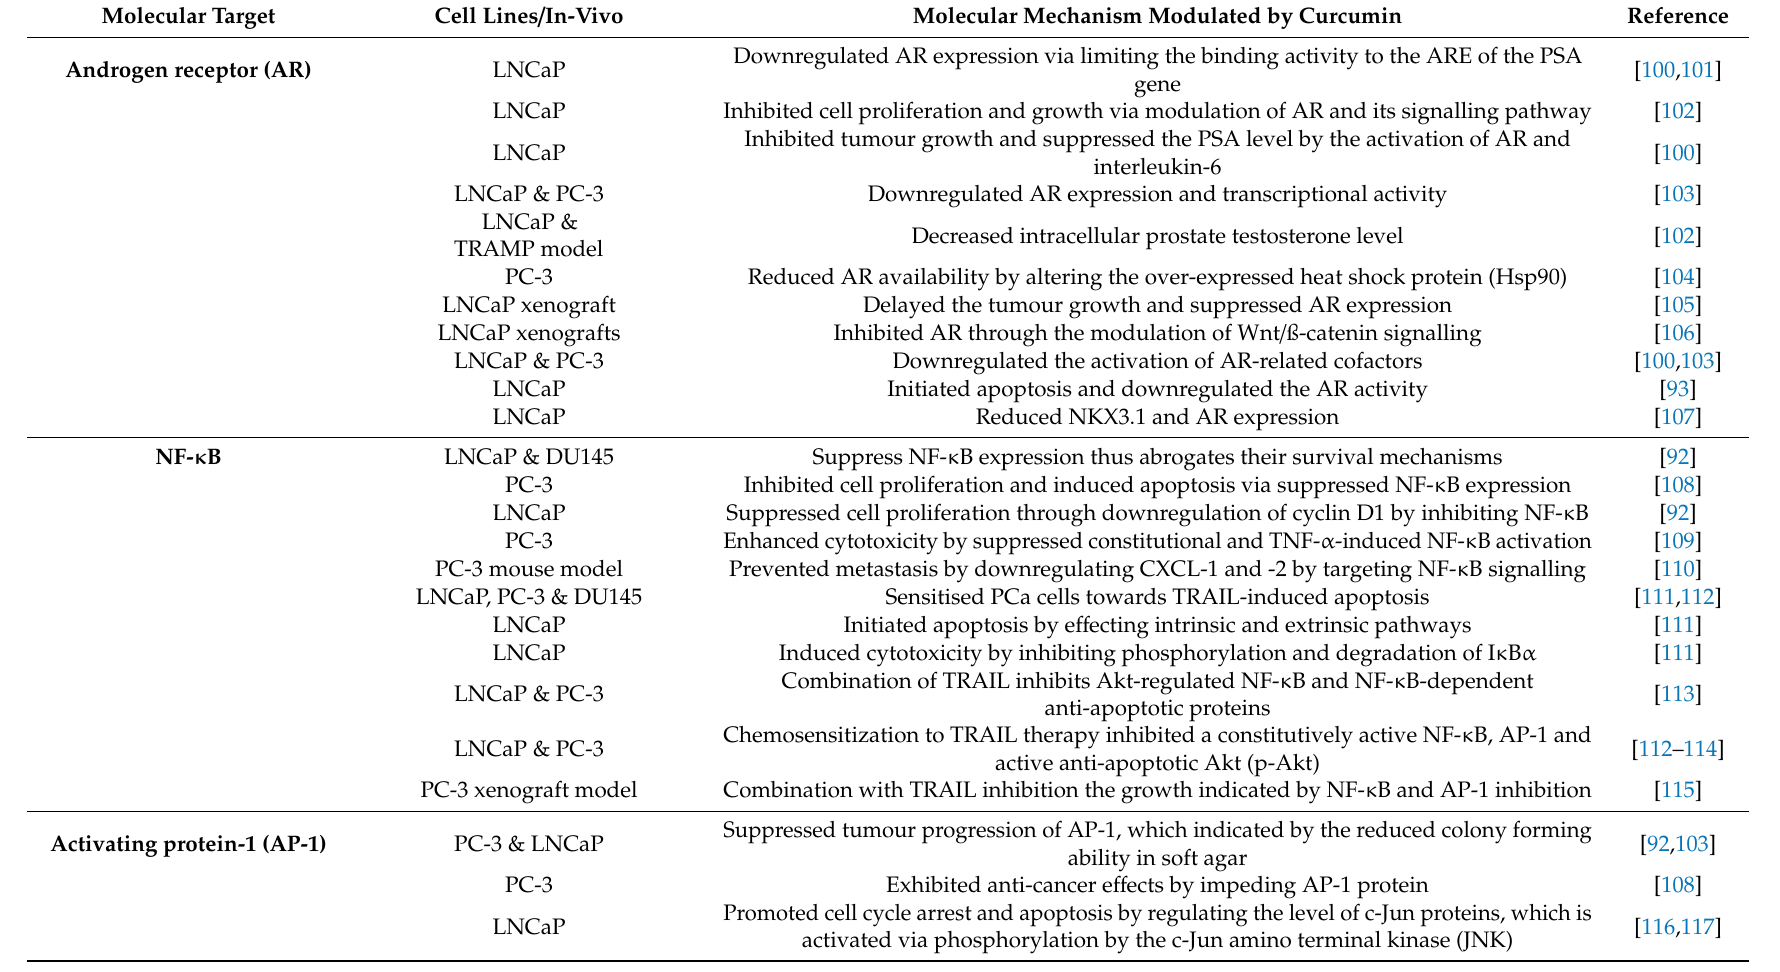
Table 1. Molecular mechanism targeted by curcumin in vivo and in vitro against androgen-dependent and androgen-independent prostate